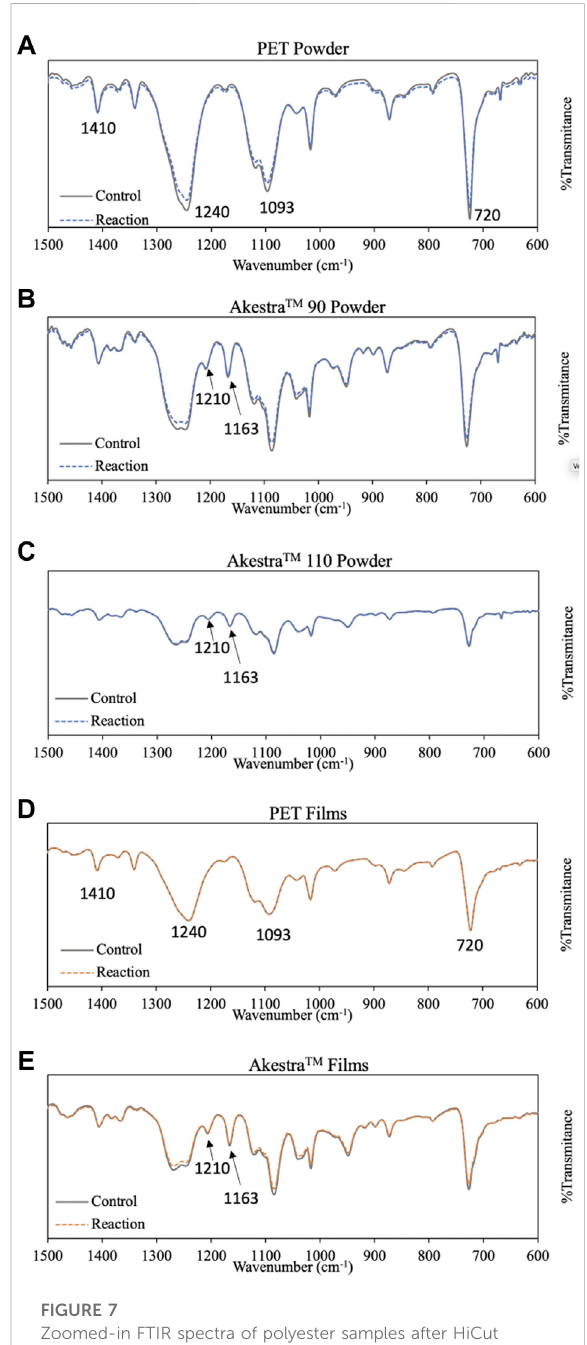
FIGURE 7 Zoomed-in FTIR spectra of polyester samples after HiCut treatment compared to the negative control samples. (A) PET Powder, (B) Akestra TM 90 Powder, (C) Akestra TM 110 powder, (D) PET fi lm and (E) Akestra TM fi lm. The data was normalized at the peak at 1410 cm − 1 as a reference (Drobota et al.,